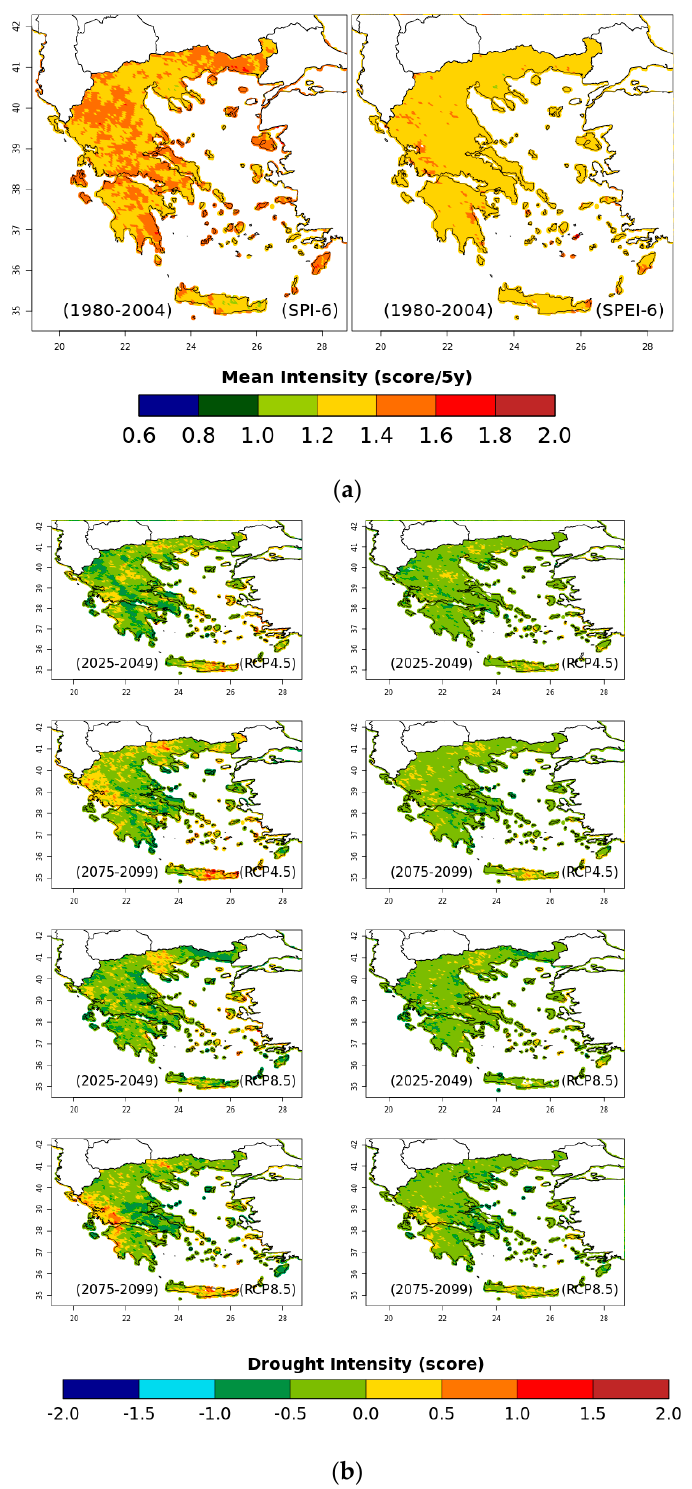
Figure 6. ( a ) Drought Intensity as the averaged values obtained for the entire reference period (1980–2004) for the SPI and the SPEI indices computed at a 6 − month timescale. ( b ) Changes in the intensity for the 6 − month SPI and SPEI for the near future period (2025–2049) and the far future (2075–2099) relative to the reference period (1980–2004) under RCP4.5 and RCP8.5.